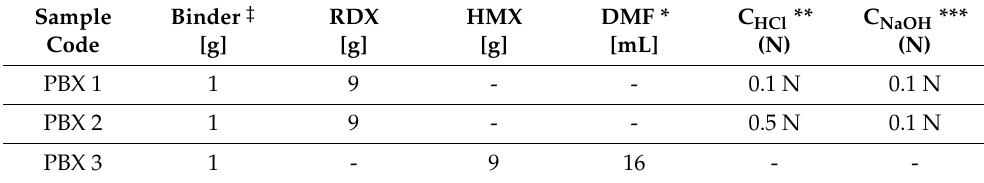
Table 1. Composition of energetic